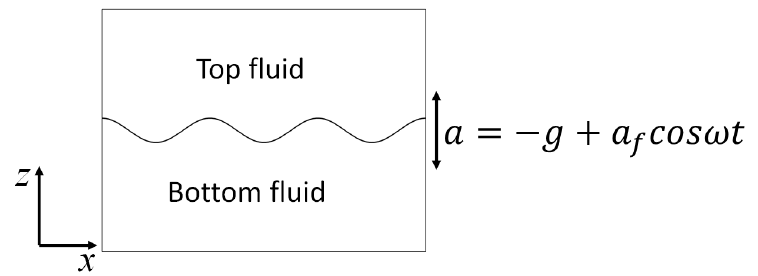
Figure 1. Schematic distribution of fluids in the two-dimensional